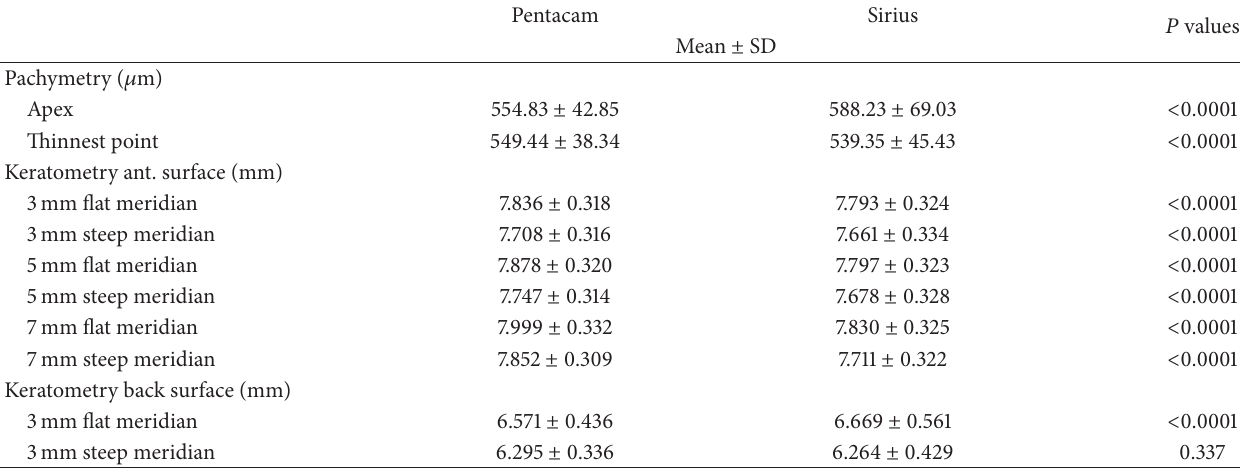
Table 6: Interdevice differences of the two devices in healthy